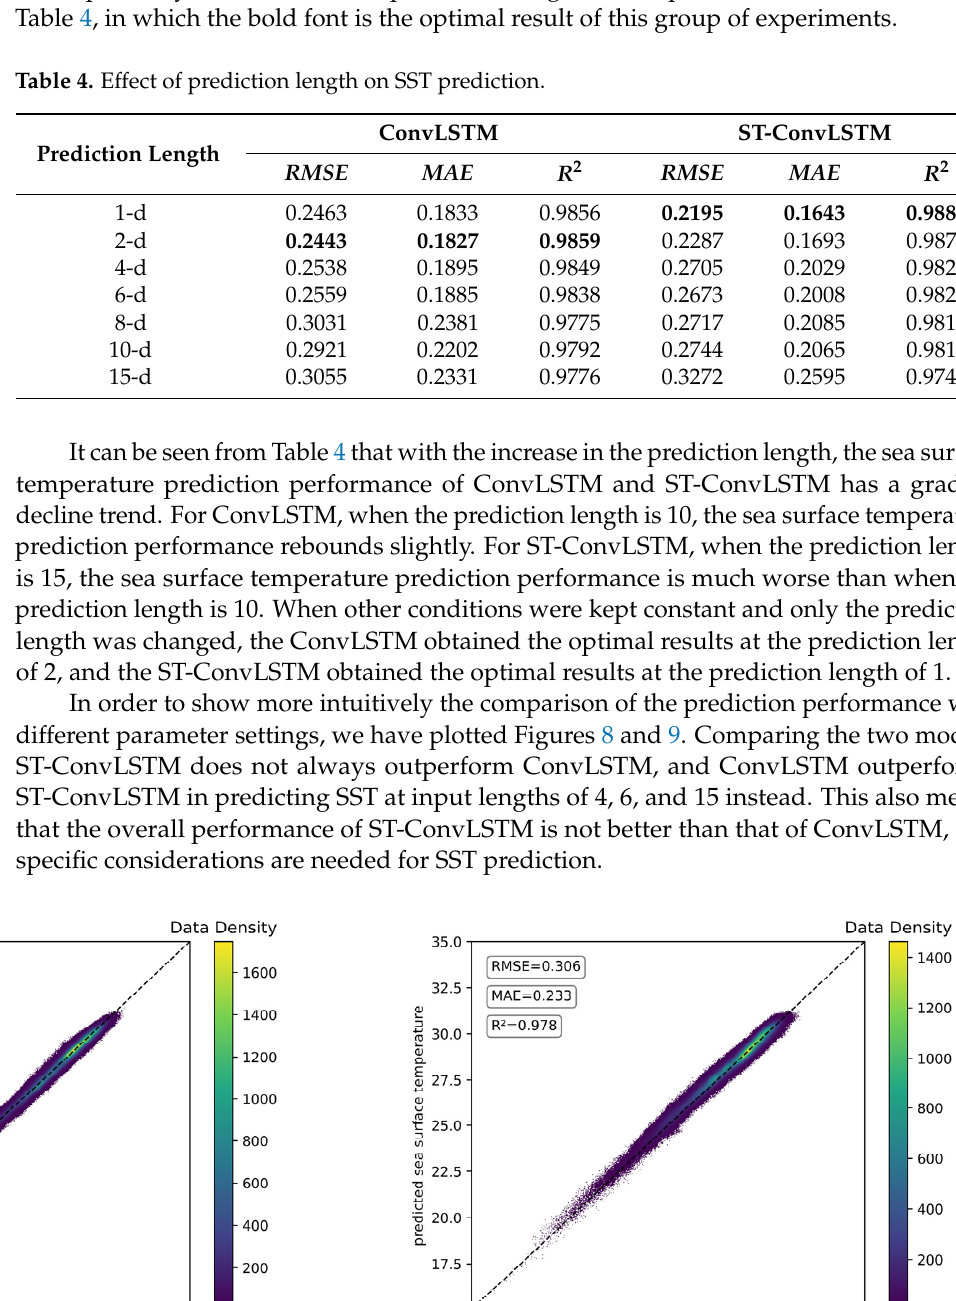
Figure 9. Comparison of SST prediction performance using ST-ConvLSTM. On the left, the predic- tion length is set to 1, and on the right, it is set to 15.